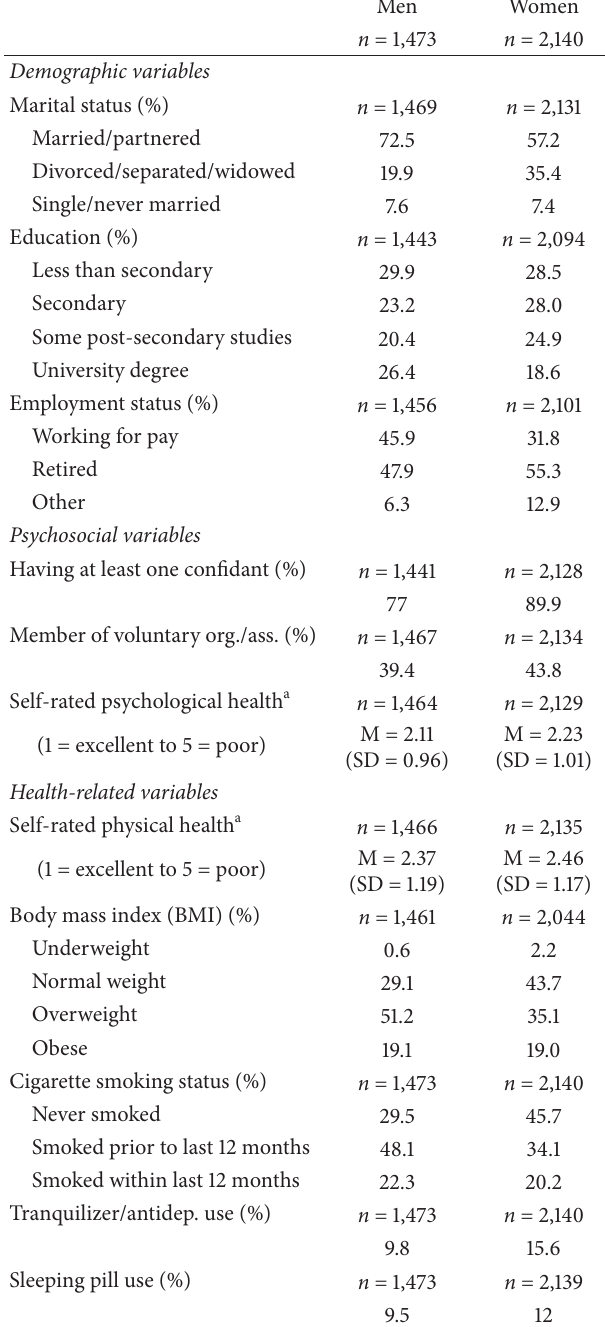
Table 2: Demographic, psychosocial, and health-related character- istics (control variables) of men and women, 55–74 years of age ( 𝑛 =